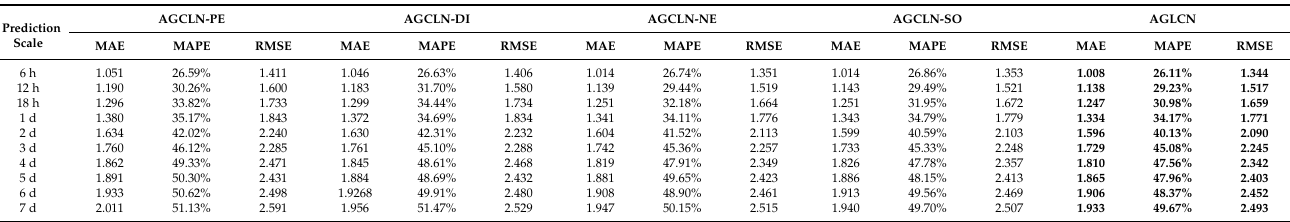
Table 9. The prediction results of the ablation study at 40